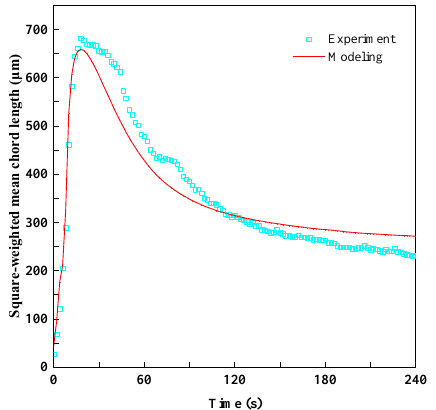
Figure 8. ( a ) Collision efficiency and ( b ) breakage rate coefficient in PBM under the optimal conditions. The dynamic evolution of the square-weighted mean chord length of floc obtained by modeling under the optimal conditions can be obtained, as shown in Figure 9.